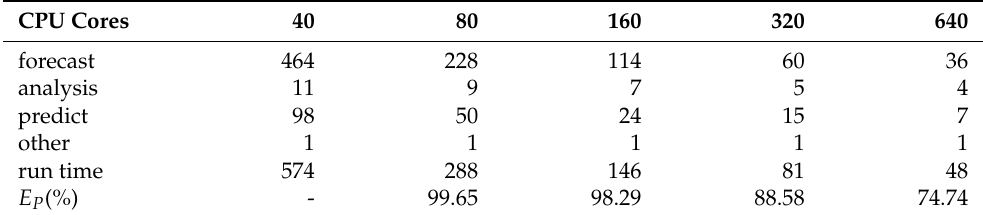
Table 6. The computational time and parallel efficiencies for the known endpoint example (time unit: